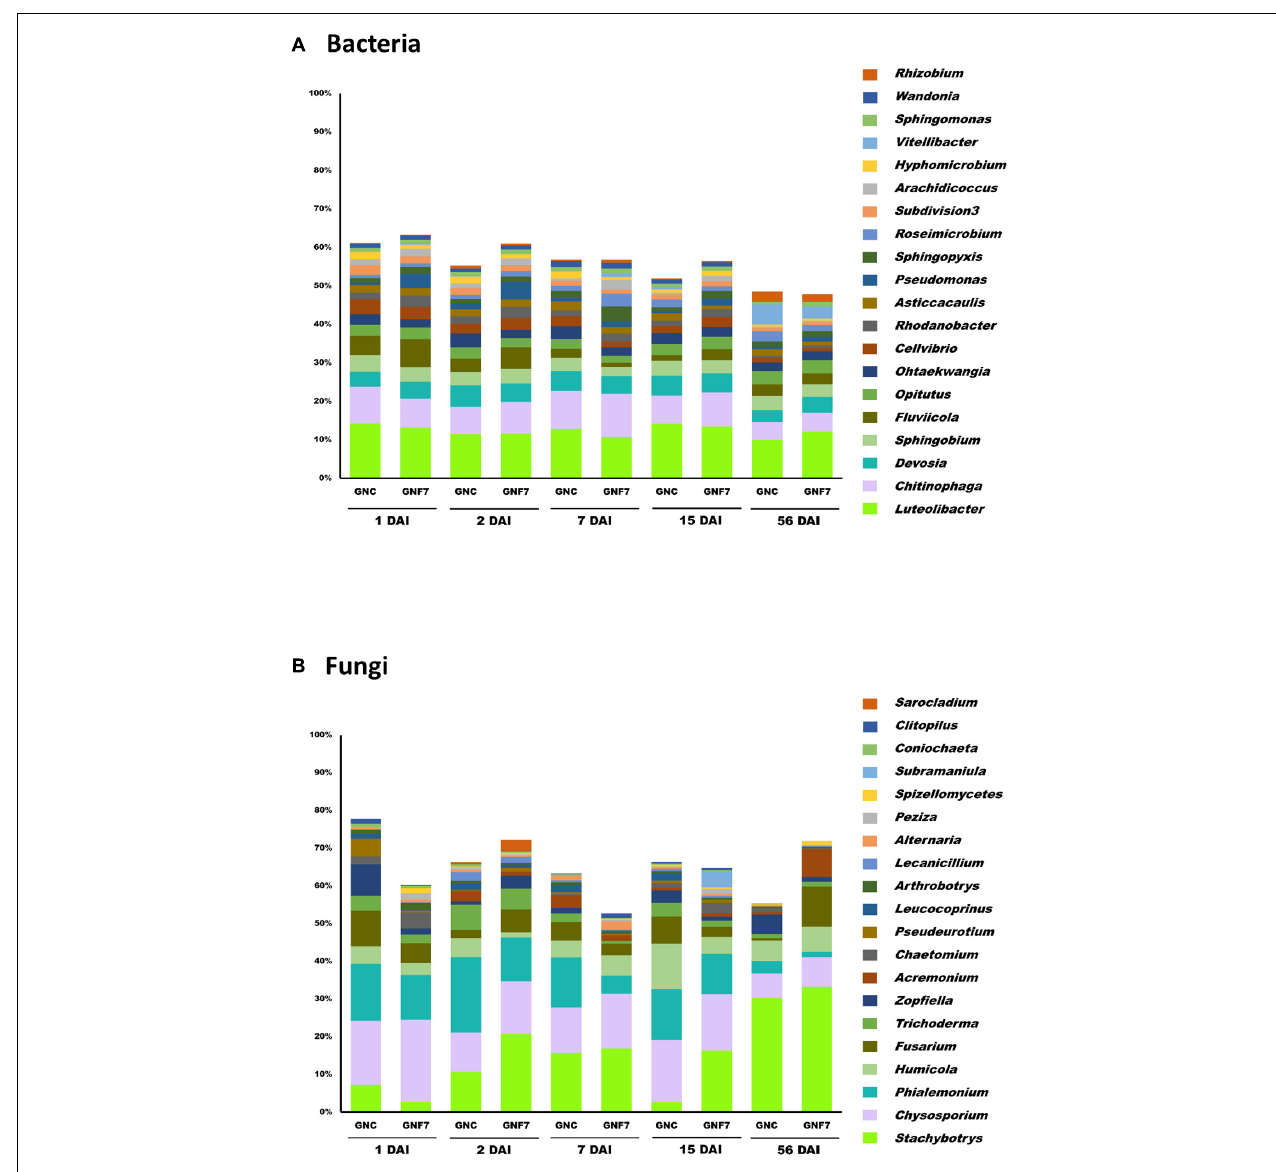
FIGURE 2 | Bacterial (A) and fungal (B) taxonomic profiles at the genus level of banana (cv. Grand Nain) roots non-inoculated (GNC) and inoculated (GNF7) with strain PICF7 at 1, 2, 7, 15, and 56 days after inoculation (DAI). Only the main genera (with a relative abundance ≥ 1%) are shown ( n =